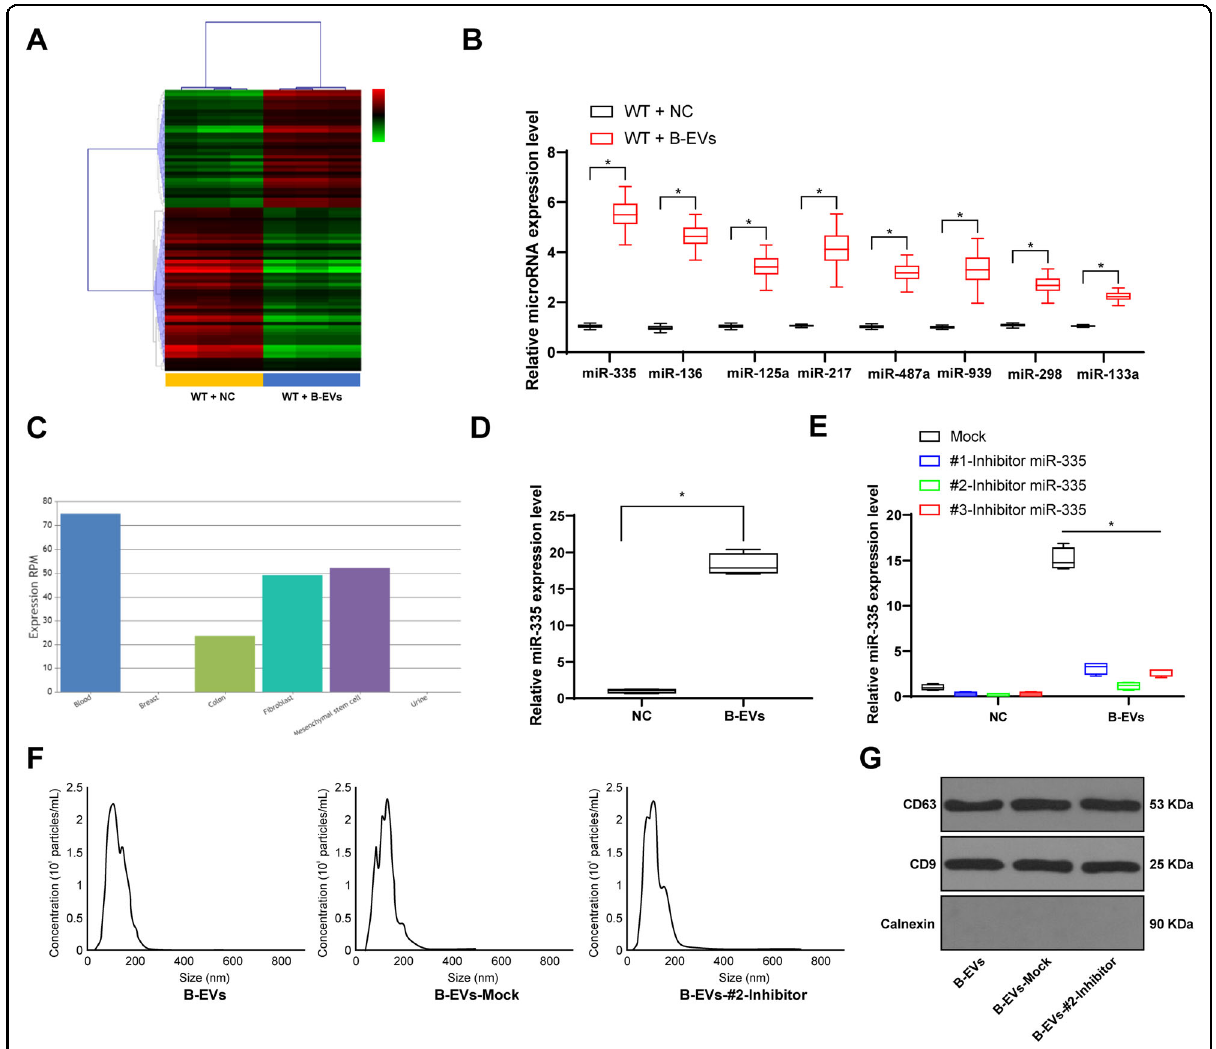
expression of miR-335, miR-136, miR-125a, miR-217, miR-487a, miR-339, miR-298, and miR-133a in femurs of WT mice to validate microarray data. C EvimicroRNA predicted miR-335 distribution. D RT-qPCR was performed to determine miR-335 expression in the conditioned medium after GW4869 intervention and EVs. E RT-qPCR was performed to determine miR-335 expression after miR-335 Mock or inhibitor was transfected. F The concentration and particle size of B-EVs transfected with 2#-Inhibitor were measured by NTA. G Western blot was used to detect the expression of CD63, CD9, and Calnexin on the surface of B-EVs transfected with 2#-Inhibitor. Data are expressed as mean ± standard deviation. Two-way ANOVA and Tukey ’ s multiple comparisons test were used to determine statistical signi fi cance. * p < 0.05. Four independent experiments were